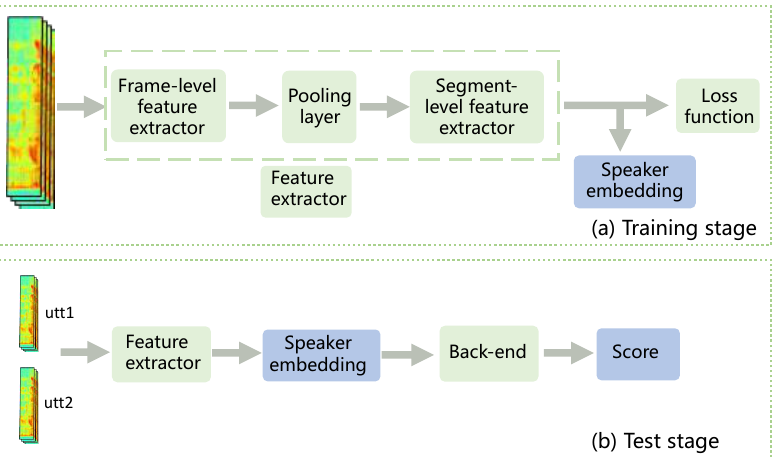
Figure 1. Speaker verification system